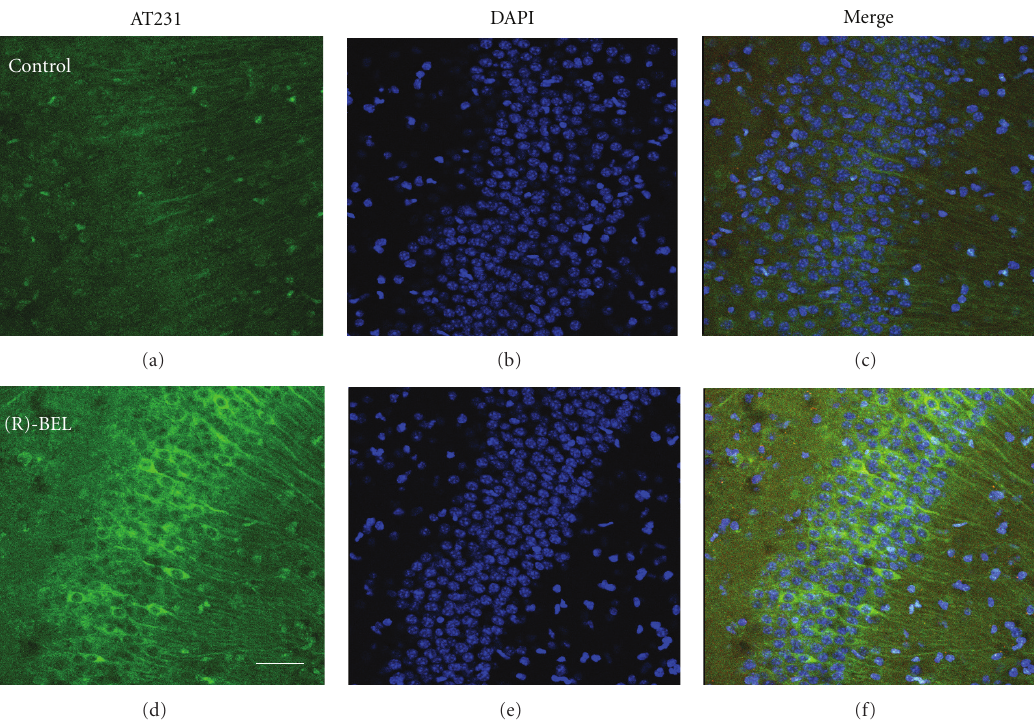
Figure 2: Inhibition of iPLA 2 γ induces Tau phosphorylation in area CA1 of hippocampus. Cultured hippocampal slices from P301L Tau transgenic mice were treated with the iPLA 2 γ inhibitor (R)-BEL. Slices were then processed for confocal immunofluorescence microscopy with an antibody recognizing Tau phosphorylation at Threonine 231 epitopes (AT231, in green) (AbCam, Cambridge, MA, USA. Dilution 1:750). When compared to controls (upper panel), immunostaining revealed increased phosphorylation in the CA1 region of cultured hippocampal slices incubated with 3 μ M (R)-BEL for a period of 12 h (lower panel). DAPI (in blue) was included in the mounting medium to label nuclei. This observation was qualitatively reproduced in hippocampal slices obtained in 3 di ff erent cultures. Scale bar = 25 μ m.